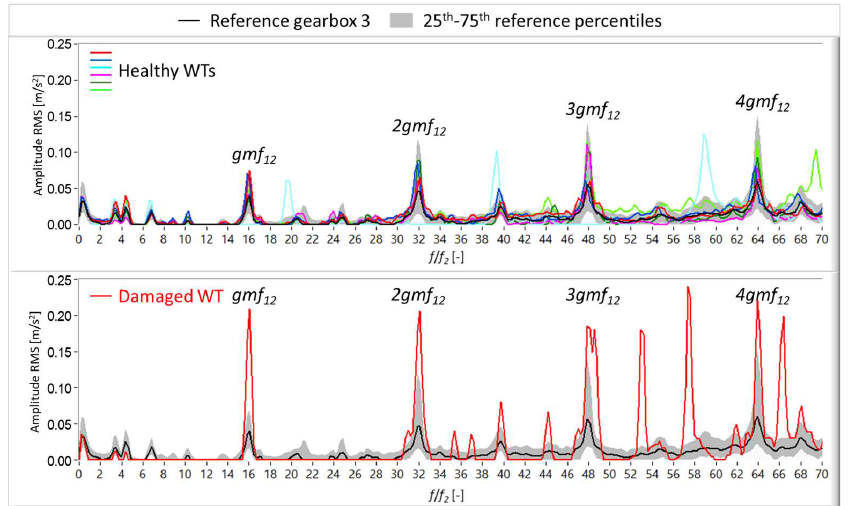
Figure 16. Comparison of the reference median spectrum (black line) and amplitude levels between 25th and 75th percentiles (grey region) of the gearbox vibrations obtained from all the WTs with the particular median spectra of each healthy WT ( top graph ) and with the median spectrum of the damaged WT ( bottom graph ).